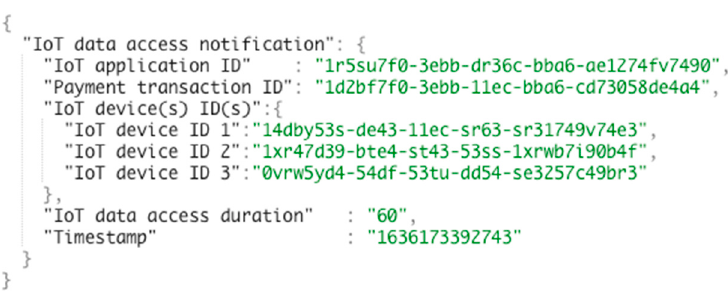
Figure 4. IoT device payment transaction with paying three IoT devices example.